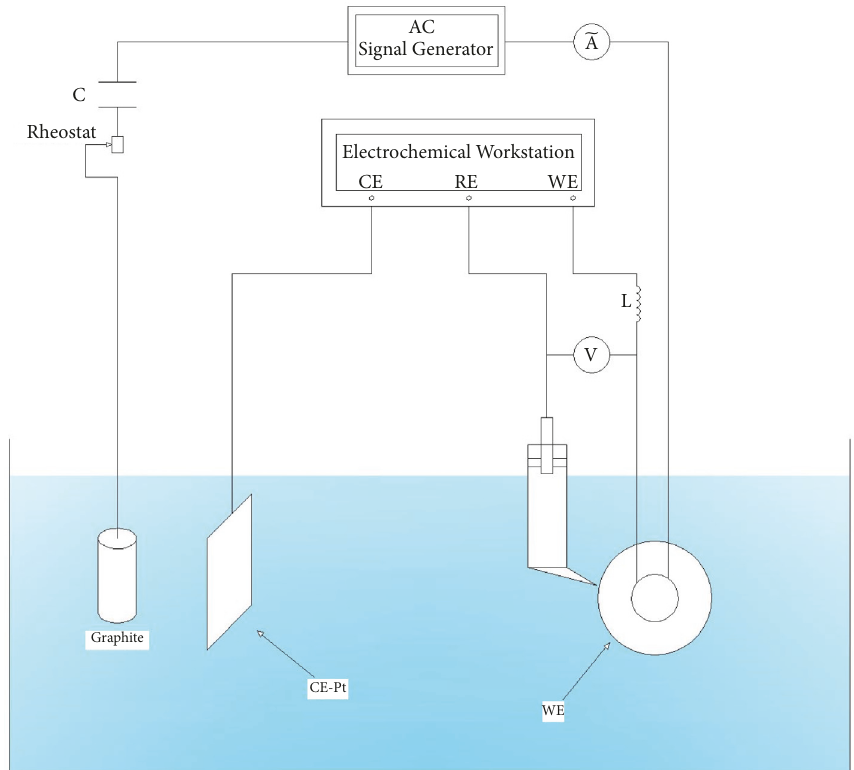
Figure 1: Schematic diagram of the